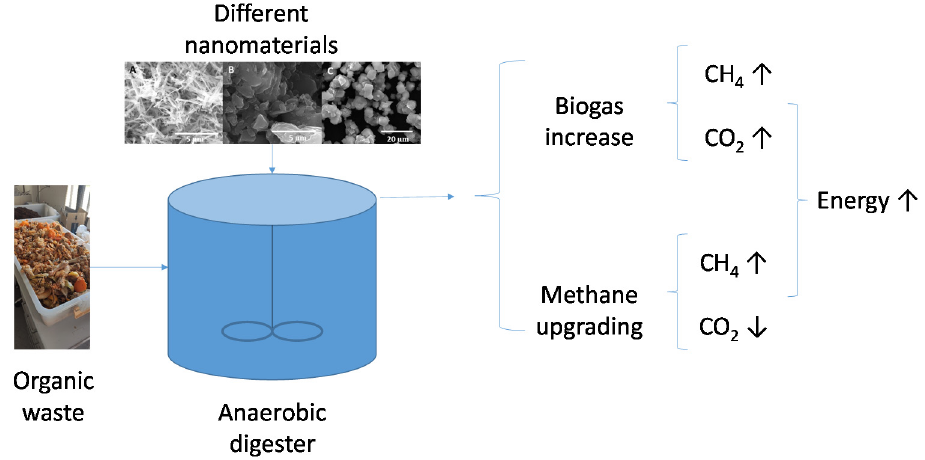
Figure 1. Possible benefits involved in anaerobic digestion with nanoparticles.